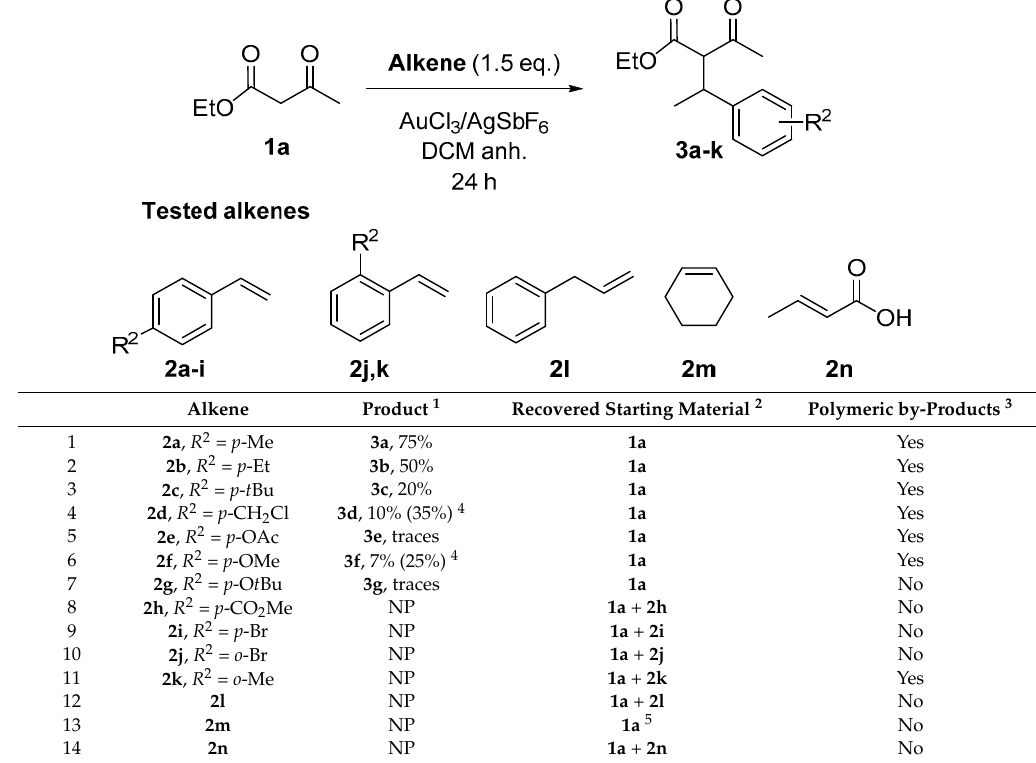
Molecules 2018 , 23 , x Table 2. Evaluation of olefin influence in the AuCl 3 /AgSbF 6 –promoted Table 2. Evaluation of olefin influence in the AuCl 3 /AgSbF 6 –promoted hydroalkylation.